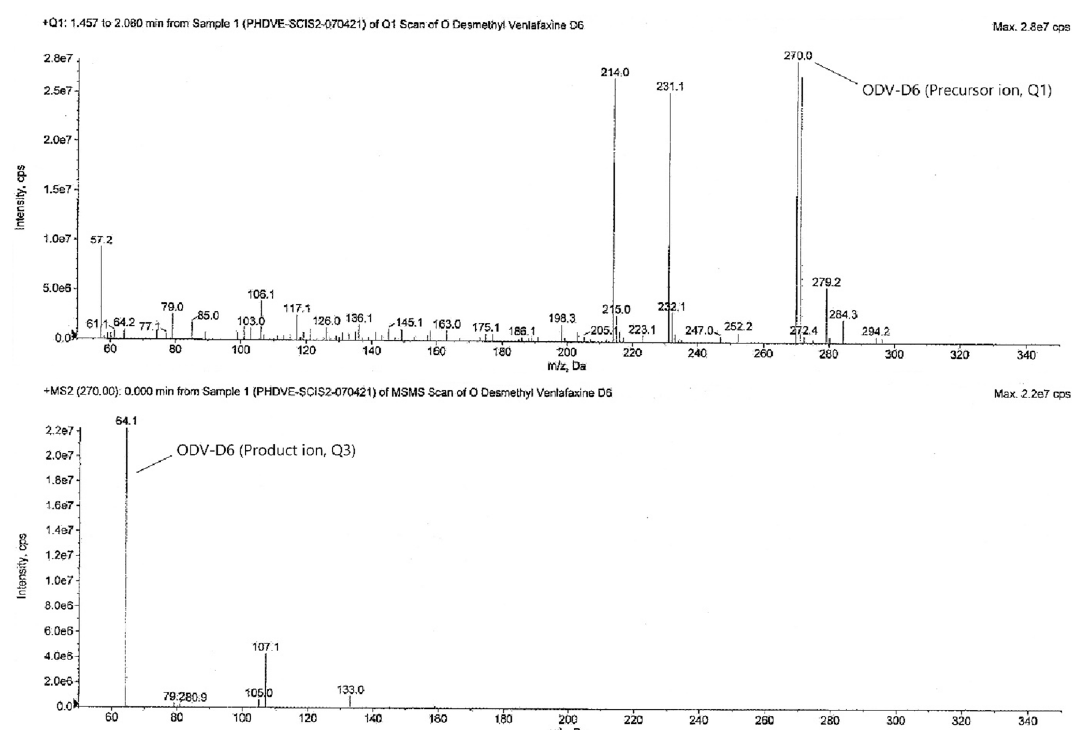
Figure 5. MRM mass spectra and fragmentation of O